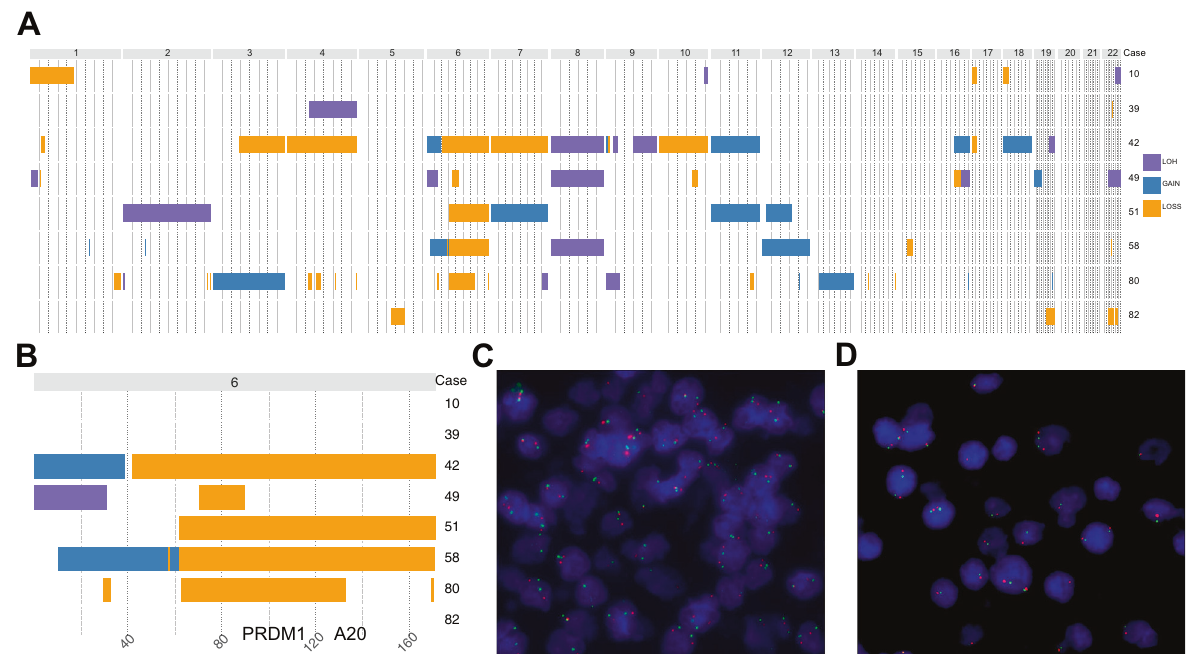
Fig. 2 Copy number variants (CNVs) in EBV + DLBCL (NOS) identi fi ed through whole-genome sequencing. Panel ( A ) depicts whole genomic CNAs, whereas panel ( B ) illustrates the recurrent 6q losses subsequently validated by FISH (A20 in spectrum orange, PRDM1 in spectrum green) with panel displaying a wild-type constellation ( C ) and panel showing a case with a deletion of the A20 and PRDM1 gene locus in 6q ( D